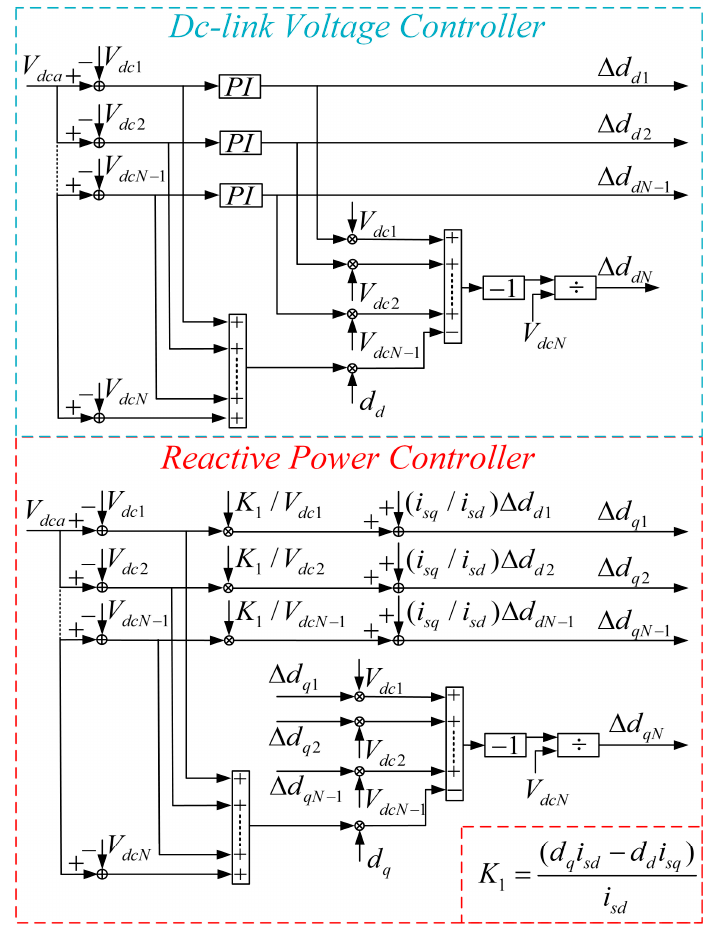
Figure 3. The block diagram of the proposed voltage-balancing controller (VBC).